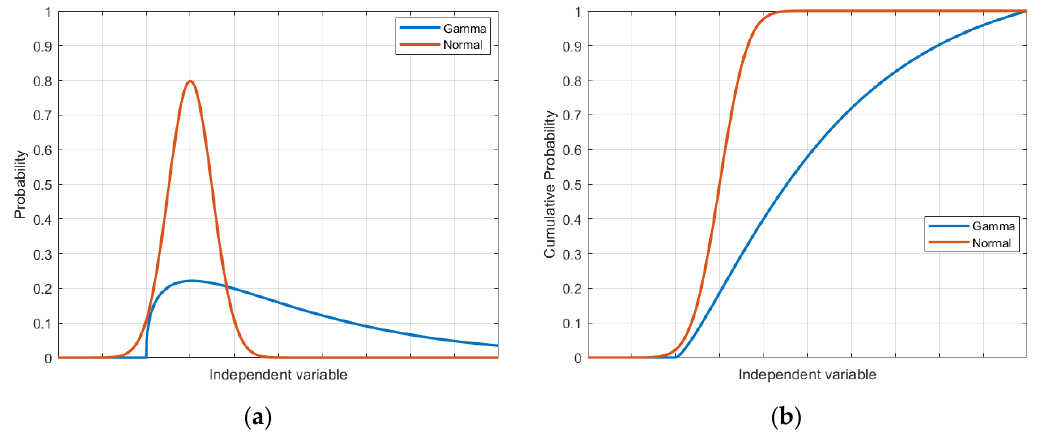
Figure 1. Uncertainty characterization: ( a ) probability distribution functions; ( b ) cumulative proba- bility distribution functions.